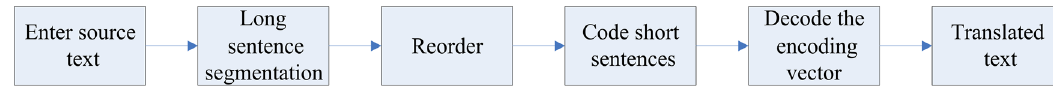
Figure 2: Translation process of the improved intelligent machine translation algorithm for long English